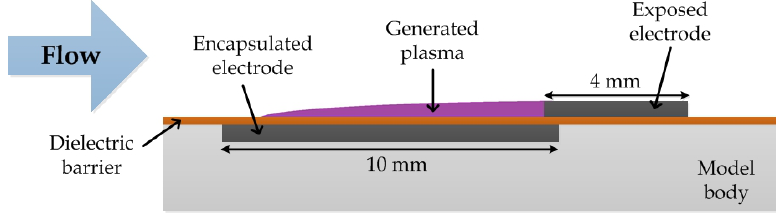
Figure 2. Scheme of the dielectric barrier discharge (DBD)